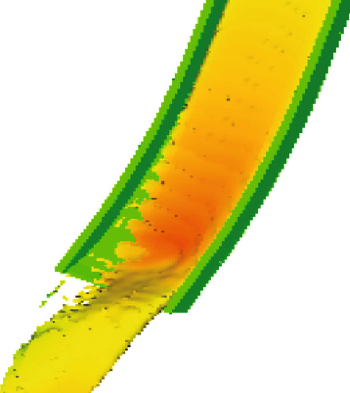
Figure 10: The stagnation zone of fl ow in the ski